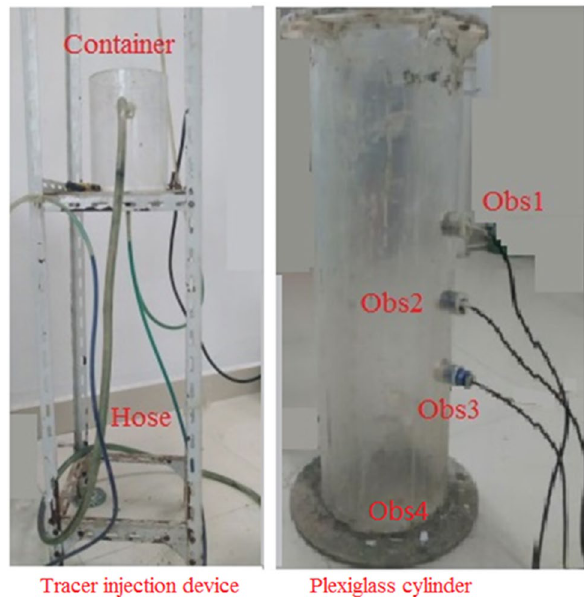
Figure 1. Physical map of the experimental device.